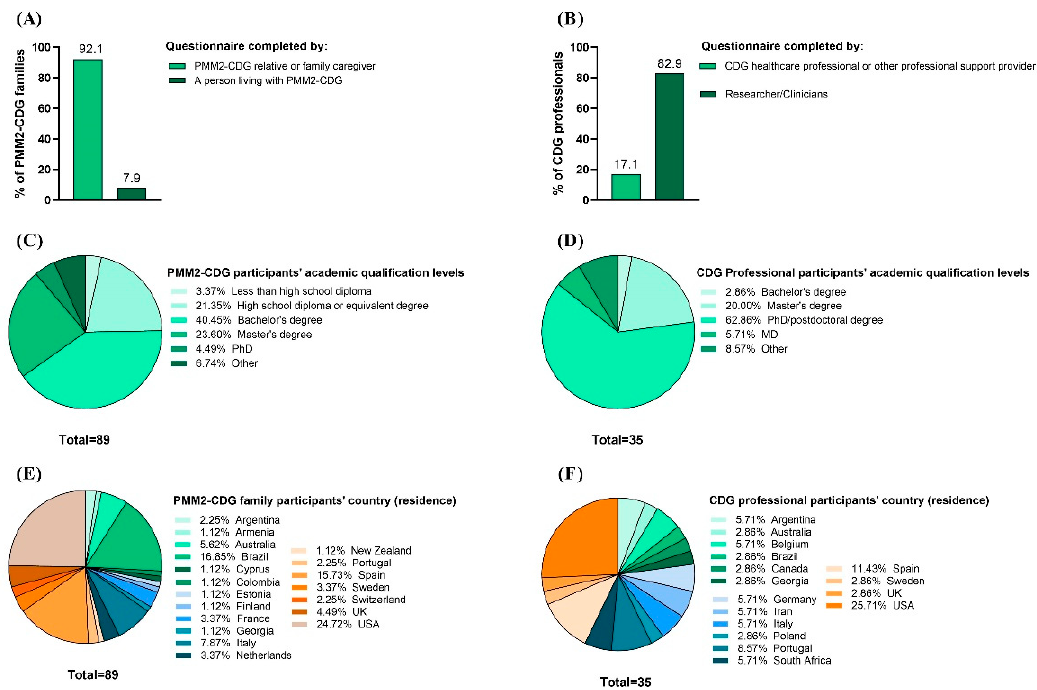
Figure 3. Characteristics of the CDG Journey Mapping e-Questionnaire respondents. It included PMM2-CDG family members and professional stakeholders. ( A ) Family and ( B ) professional respondents’ categories; ( C ) families’ and ( D ) professionals’ academic qualifications; ( E ) families’ and ( F ) professionals’ geographic distribution (per country of residence).